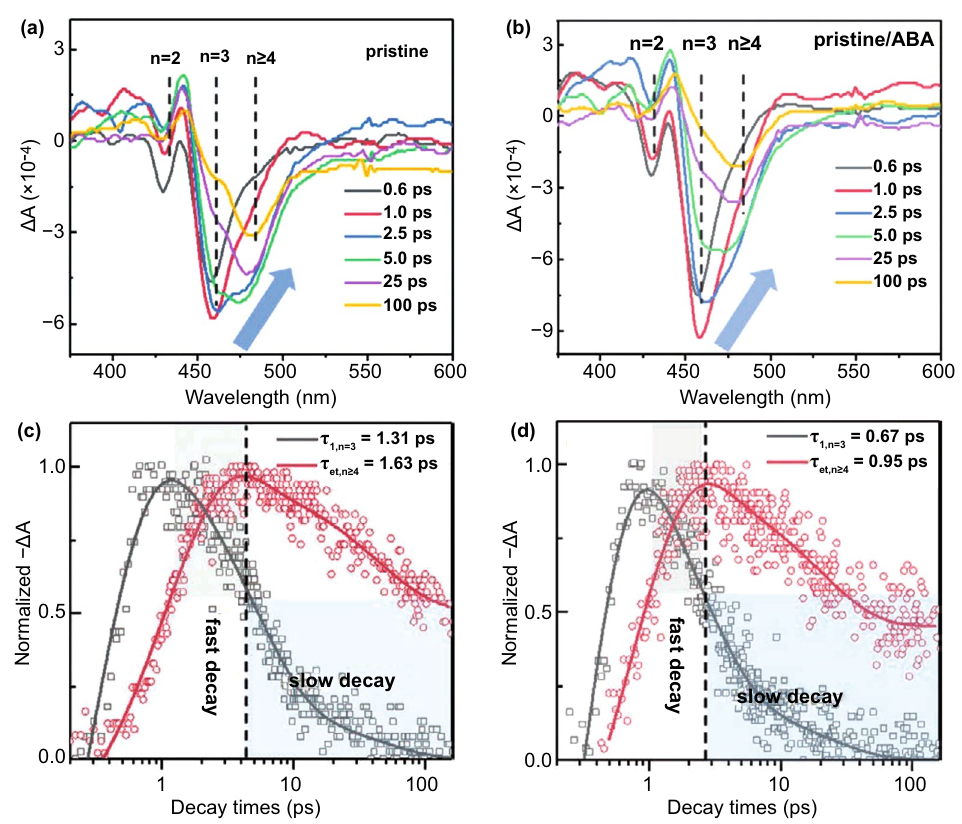
Fig. 4 TA spectroscopy of a the pristine and b pristine/ABA perovskite films. TA kinetics probed at selected wavelengths (453 and 481 nm)